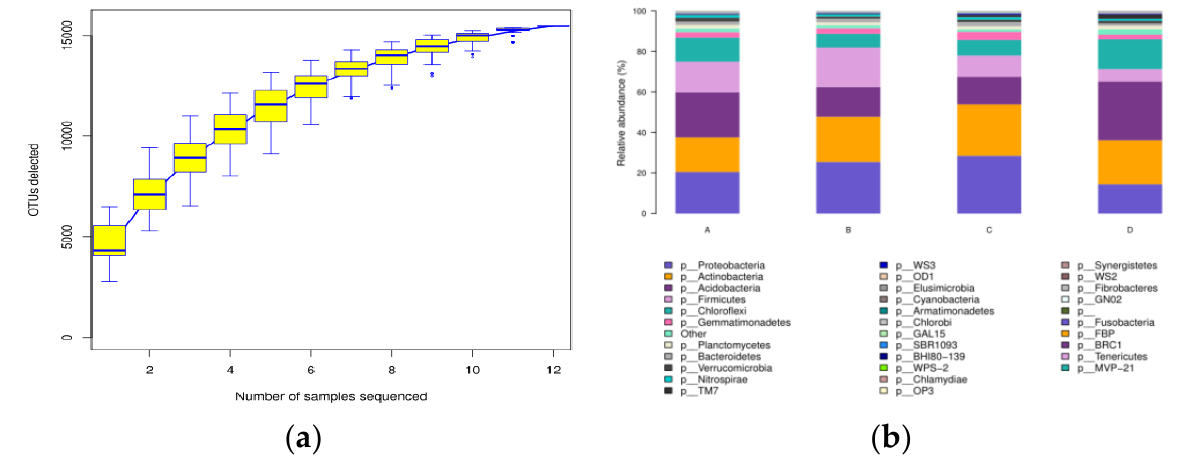
Figure 1. Species accumulation curve and Shannon diversity indices. ( a ): Species accumulation curve, ( b ): phylum-level taxonomic distribution of bacterial operational taxonomic units (OTUs) (97% cutoff). A: P. sylvestris ; B: C. microphylla ; C: S. cheilophila ; D: P. tabulaeformis. Table 1. Samples ’ alpha-diversity.